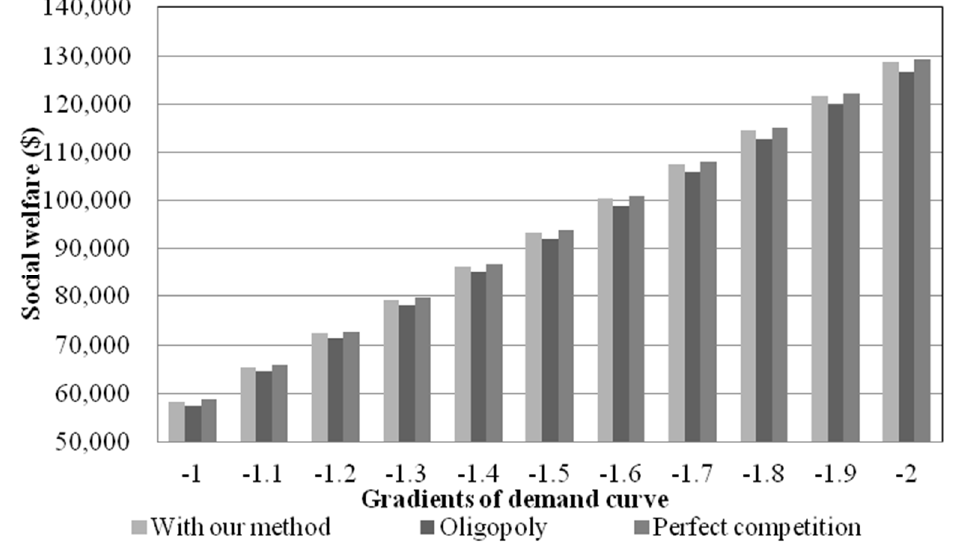
Figure 7. The social welfare for the three different